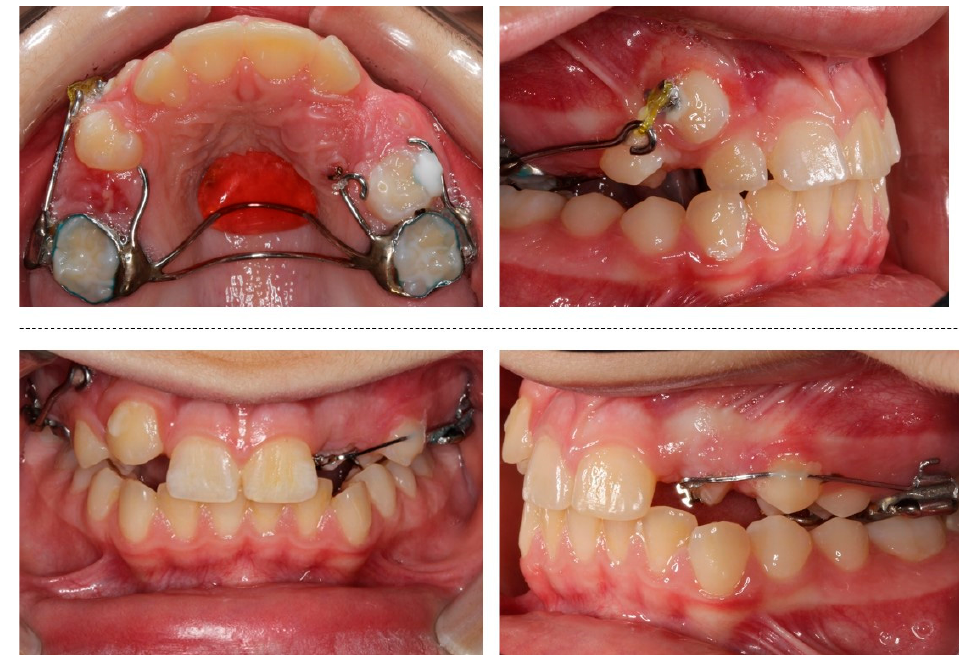
Figure 8. Sectional mechanics used for the traction of the impacted canines.